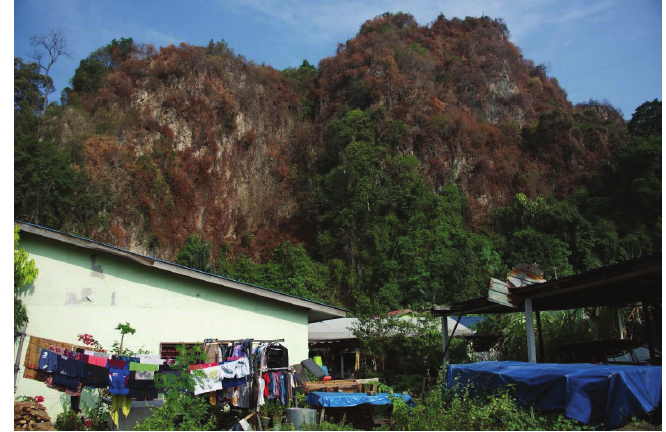
Figure 2. Aftermath of extensive accidental burning on Batu Caves.